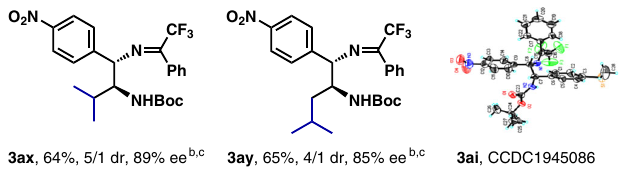
Fig. 2 Substrate scope of aldimines 2 a . Both aromatic aldimines and aliphatic aldimines are employed. a 1a : 0.2 mmol, 2 : 0.3 mmol. Isolated yield. Dr determined by 1 H NMR analysis of the crude reaction mixture. Enantioselectivity determined by chiral-stationary-phase HPLC analysis. b 4 equiv 2 . c The reaction is performed with 10 mol % mesitylcopper and 10 mol % ( R , R P )-TANIAPHOS in THF at RT for 8 accomplished by means of a powerful reaction protocol. The 0.01 mmol, 5.0mol %) and ( R , R p)-TANIAPHOS (6.8 mg, 0.01mmol, 5.0mol %) in a glove box under Ar atmosphere. Anhydrous DME (2 mL) was added via a syr- capture of the benzyl copper(I) species and its further application inge. The mixture was stirred for 20 min at room temperature to give a yellow in asymmetric catalysis are currently ongoing in our laboratory. solution. The reaction mixture was cooled to − 30 °C, and benzyl imine (0. 2mmol, 1.0 equiv) and N -Boc-aldimine (0.3mmol, 1.5 equiv) were added. The resulting reaction mixture was stirred at − 30 °C for 18h. Then, the reaction mixture Methods was puri fi ed by silica gel column chromatography (petroleum ether/ethyl acetate = A general procedure for aromatic aldimines . A dried 25-mL schlenk tube 12/1) to give the desired product. equipped with a magnetic stirring bar was charged with mesitylcopper (1.8mg,